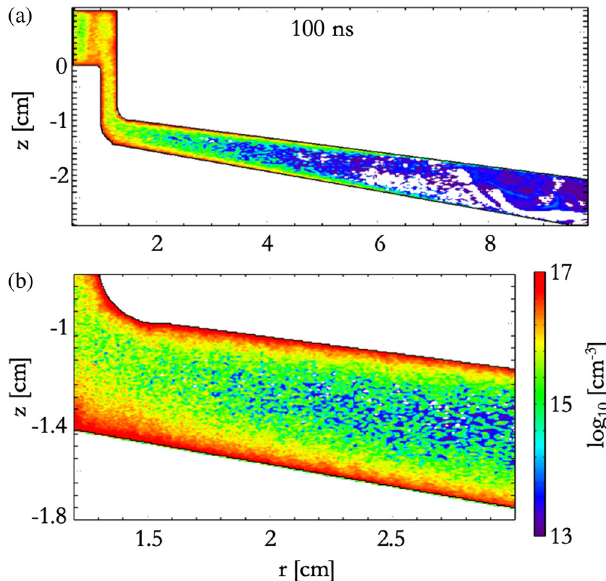
FIG. 13. The simulated and measured currents delivered to the load ( I ) for the geometry in Fig. 3(a) (solid) and a variant load with similar inductance (dashed). The measurement uncertainty is (cid:3) 5%